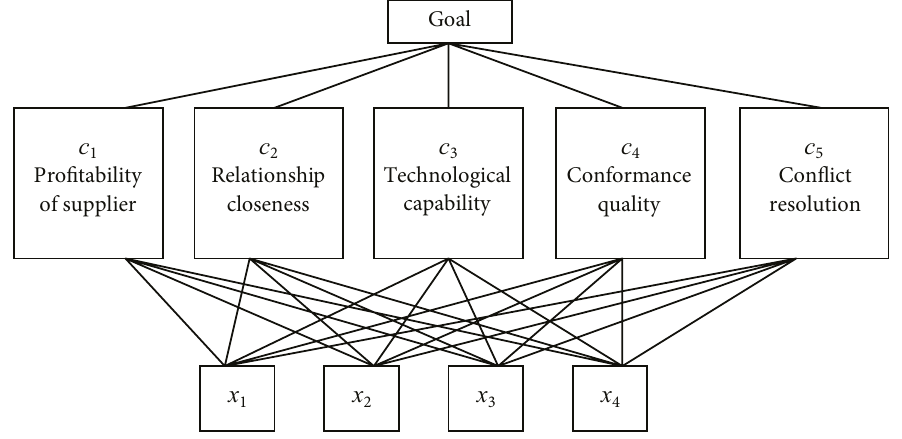
Fig. 1. Hierarchical structure of decision